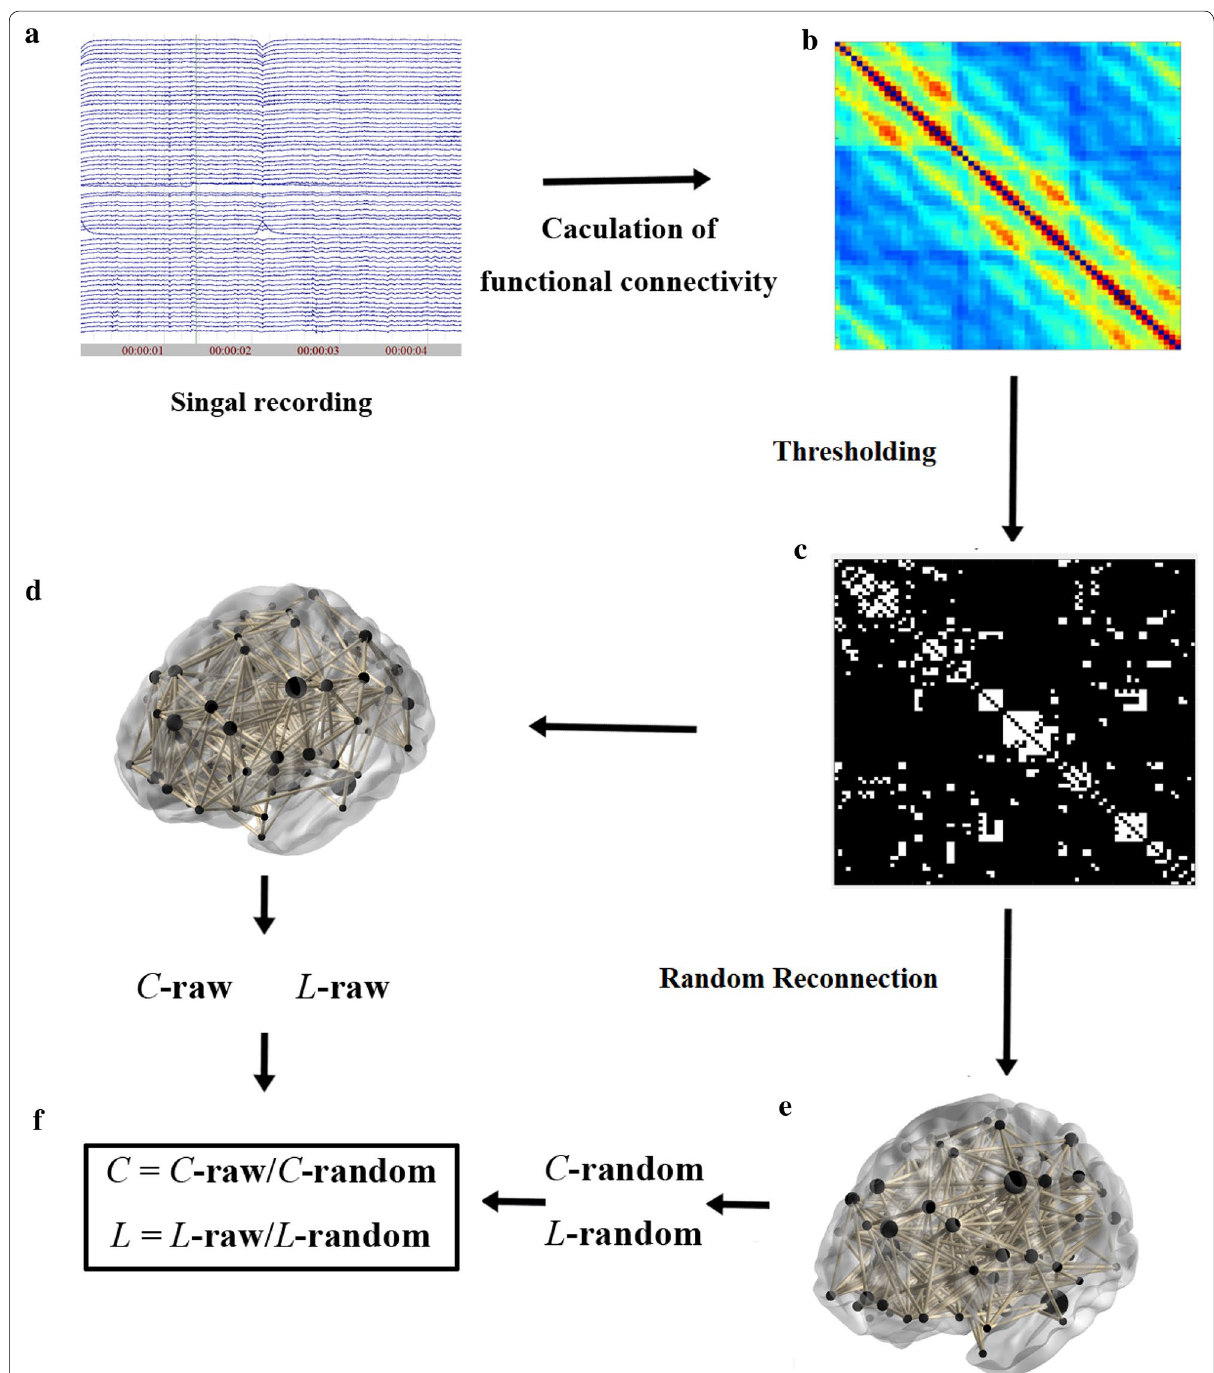
Fig. 4 A workflow from functional connectivity measurement to brain functional network attributes. a . Neuroimaging data recorded from device, these data can be EEG, fMRI, or MEG. b Functional connectivity between brain regions is estimated from signals and form a correlation matrix. c The correlation matrix produces a binary connectivity graph by thresholding. d The visualization of binary graph. e The binary connectivity graph is randomly reconnected to produce a random reconnected graph. f The cluster coefficient ( C ) and average shortest path length ( L ) are extracted by measuring binary connectivity graph and random reconnected graph to obtain normalized brain functional network